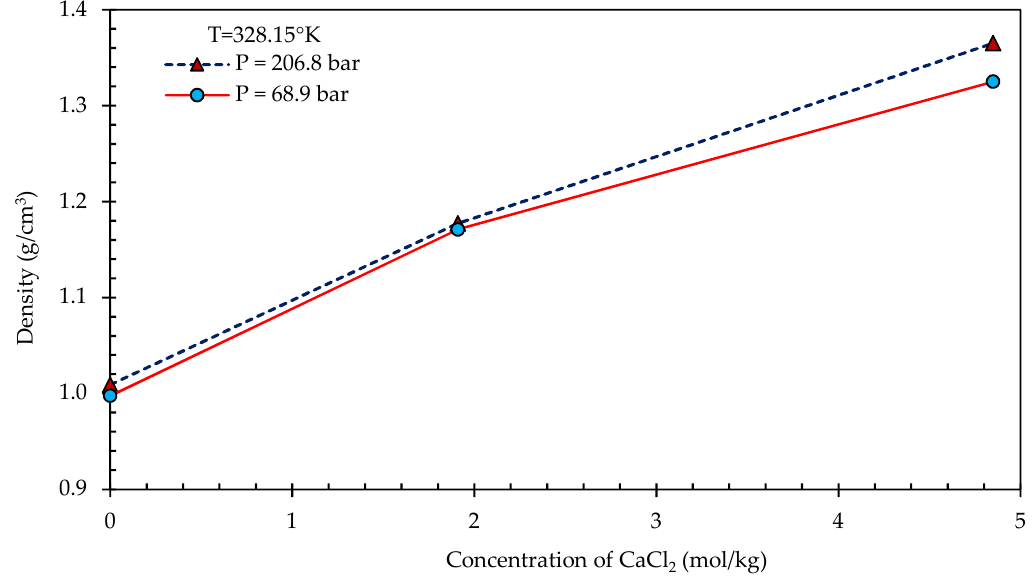
Figure 6. Experimental measurements of the density of pure H 2 O and CaCl 2 solutions saturated with CO 2 at 328.15 °K and 68.9–206.8 Bar and versus CaCl 2 concentration.